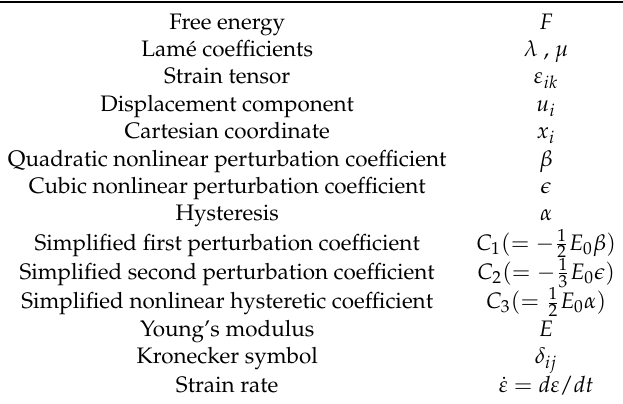
Table 1. Main symbols used in the